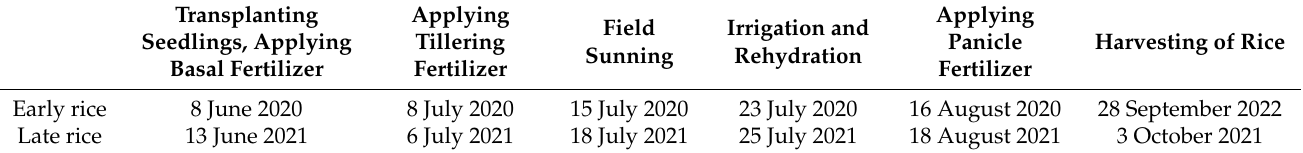
Table 1. Field management during the rice growing season in